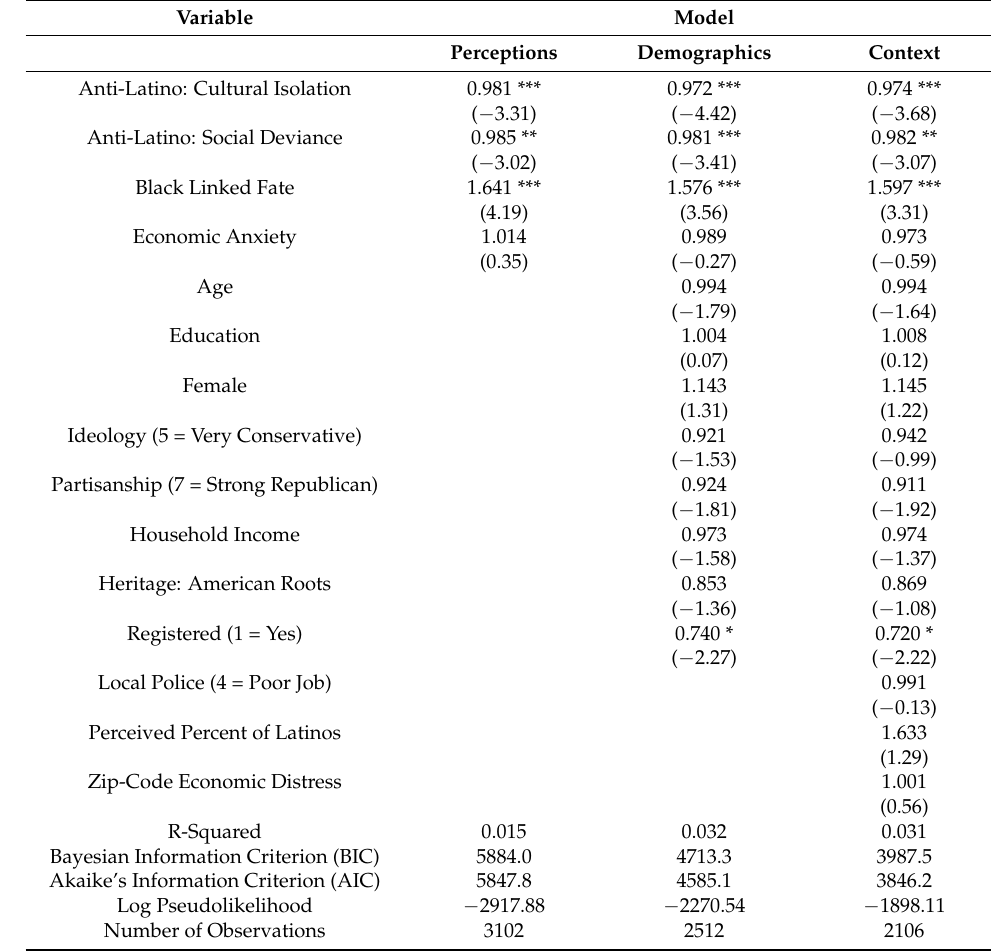
Table 5. Odds ratios from the ordinal logistic models on the importance of blacks to address challenges of black undocumented immigrants.